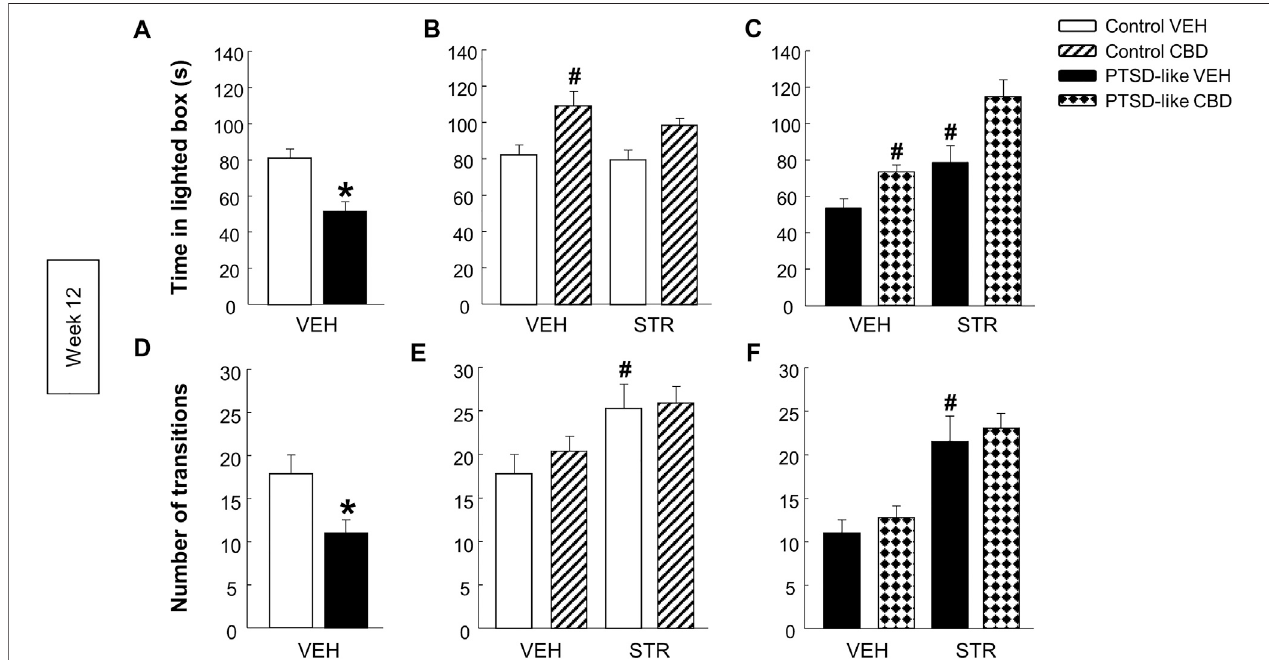
FIGURE6| Evaluationofanxiety-likebehaviorbythelight-darkbox(LDB)paradigmatweek12.ComparativeanalysisbetweencontrolandPTSD-likeVEH-treated mice of the time spent in the lighted box (s) (A) and the number of transitions (D) . Effects of CBD (20 mg/kg, i.p.) and/or STR (10 mg/kg, p.o.) administration, or its corresponding VEH, on the time spent in the lighted box (s) (B,C) and the number of transitions (E,F) of control and PTSD-like mice. Columns represent the mean and verticallines ± SEM.*,Values fromPTSD-likeVEH-treatedmicethataresigni fi cantlydifferentfrom controlVEH-treated mice(Student ’ s t -test, p < 0.001).#,Values fromCBD-orSTR-treatedgroupsthataresigni fi cantlydifferentfromVEH-treatedmice(Two-wayANOVA, p < 0.001).and,ValuesfromCBDplusSTR-treatedmicethat aresigni fi cantlydifferentfromCBD-andSTR-treatedmice(Two-wayANOVA, p < 0.001).MiceexposedtothePTSD-likemodel:N(VEH) (cid:2) 10,N(CBD) (cid:2) 10,N(STR) (cid:2) 9, N(CBD plus STR) (cid:2) 10; control mice: N(VEH) (cid:2) 10, N(CBD) (cid:2) 9, N(STR) (cid:2) 9, N(CBD plus STR) (cid:2)